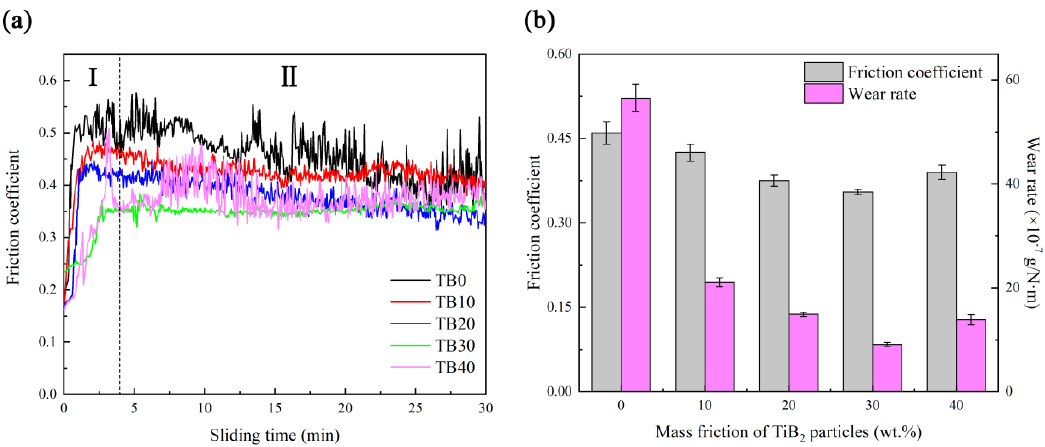
ffi cients and wear rates of